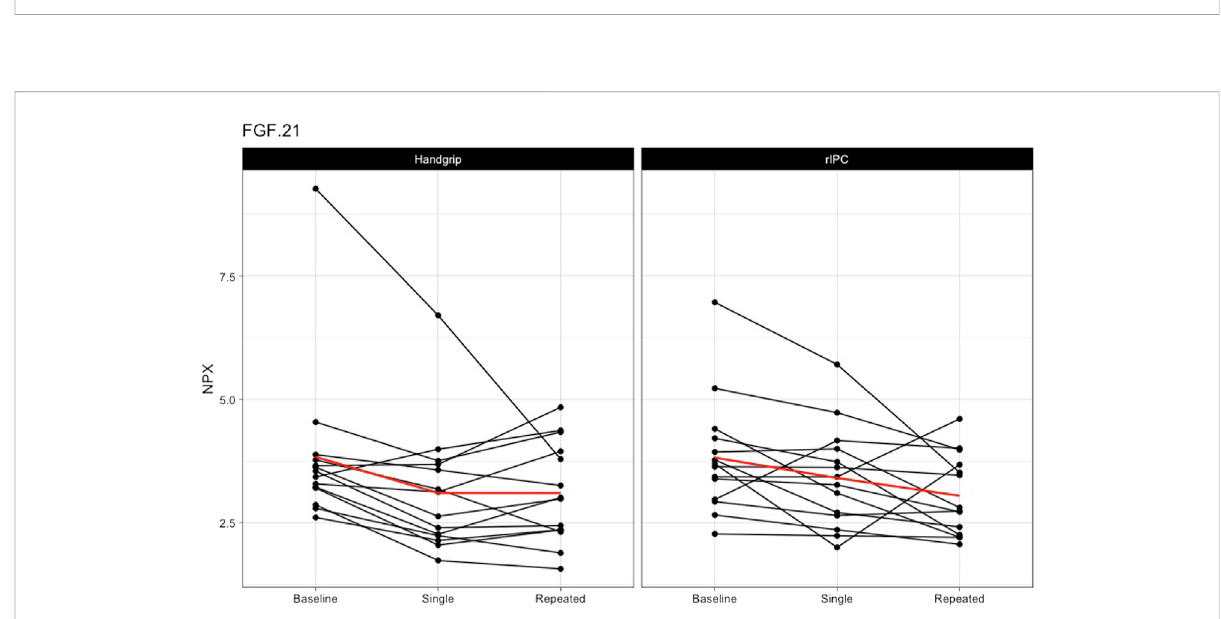
FIGURE 4 Changes in FGF-21 after single and repeated preconditioning. The changes in the NPX of FGF-21 (on the y-axis) between baseline and after single and repeated intervention (on the x-axis) for both the handgrip intervention (on the left) and the remote ischemic preconditioning (on the right). Each black line represents one participant and the red line is the mean for all the participants together. rIPC = Remote ischemic preconditioning. NPX = Normalised protein expression; FGF-21 = fi broblast growth factor